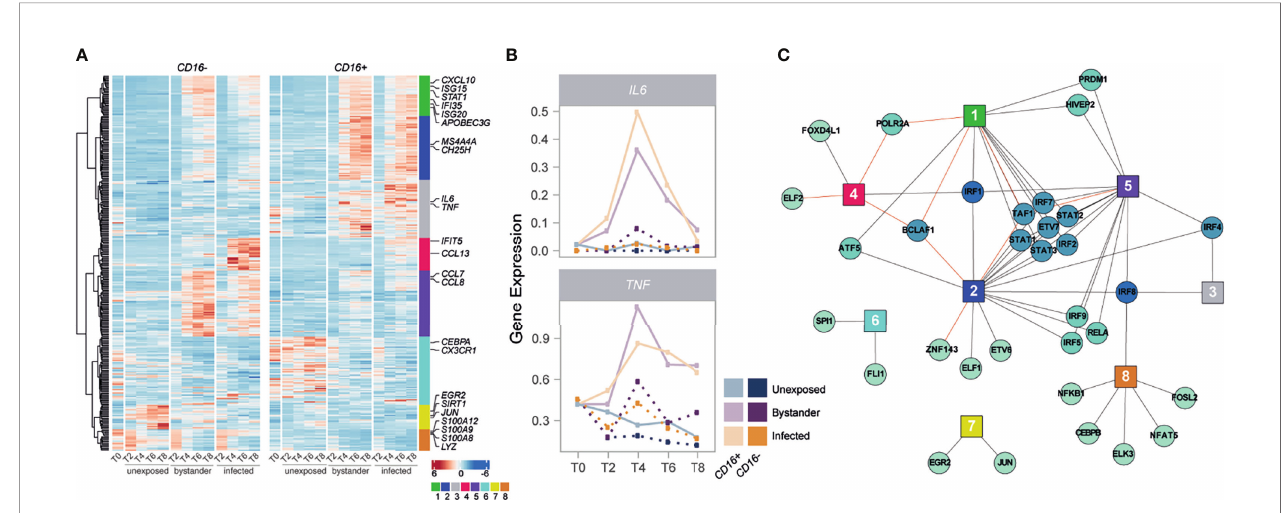
FIGURE 3 | IRFs and STATs have a central role in the subset-speci fi c responses to IAV infection. (A) Heatmap of scaled gene expression from 335 genes displaying a subset-speci fi c response to infection challenge. Genes are grouped into 8 modules based on hierarchical clustering of their expression patterns. Representative genes from each module are labelled. (B) Mean expression over time of IL6 and TNF , across the different monocyte subsets and cell states. (C) Network of transcription factors (round nodes) associated with each gene expression module (square nodes). Transcription factor nodes are colored according to the number of modules they are associated with. Black lines represent enrichments of the module in TF targets, while red lines represent